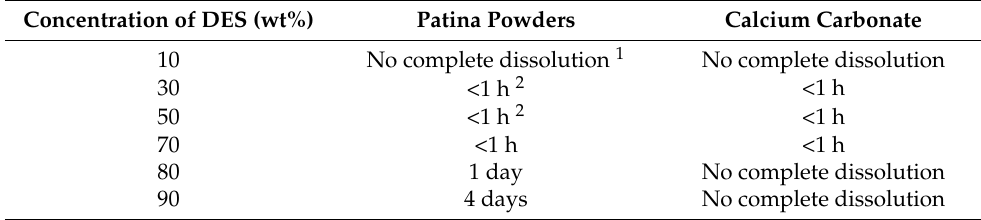
Table 1. Time required for the complete dissolution of patina and calcium carbonate in the series of DES aq. Concentration of DES (wt%) Patina Powders Calcium Carbonate 10 No complete dissolution